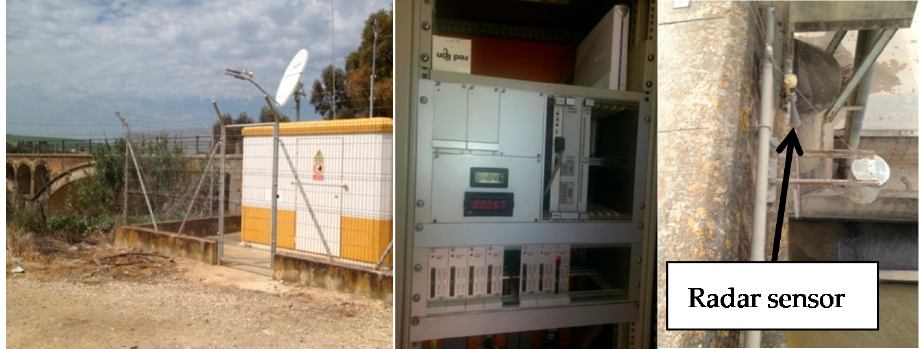
Figure 2. A17 Genil-Écija checkpoint booth with satellite dish for satellite connection with Hispasat 1ª, SAIH equipment (SAINCO/Telvent) and the Vegaplus 62 radar sensor.